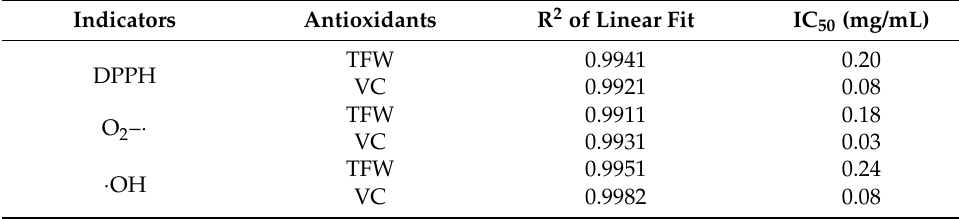
Figure 4. ( A – C ) Effect of TFW on DPPH, O 2 – · and · OH free radicals. Table 6. The results of the antioxidant activities of TFW extractives.